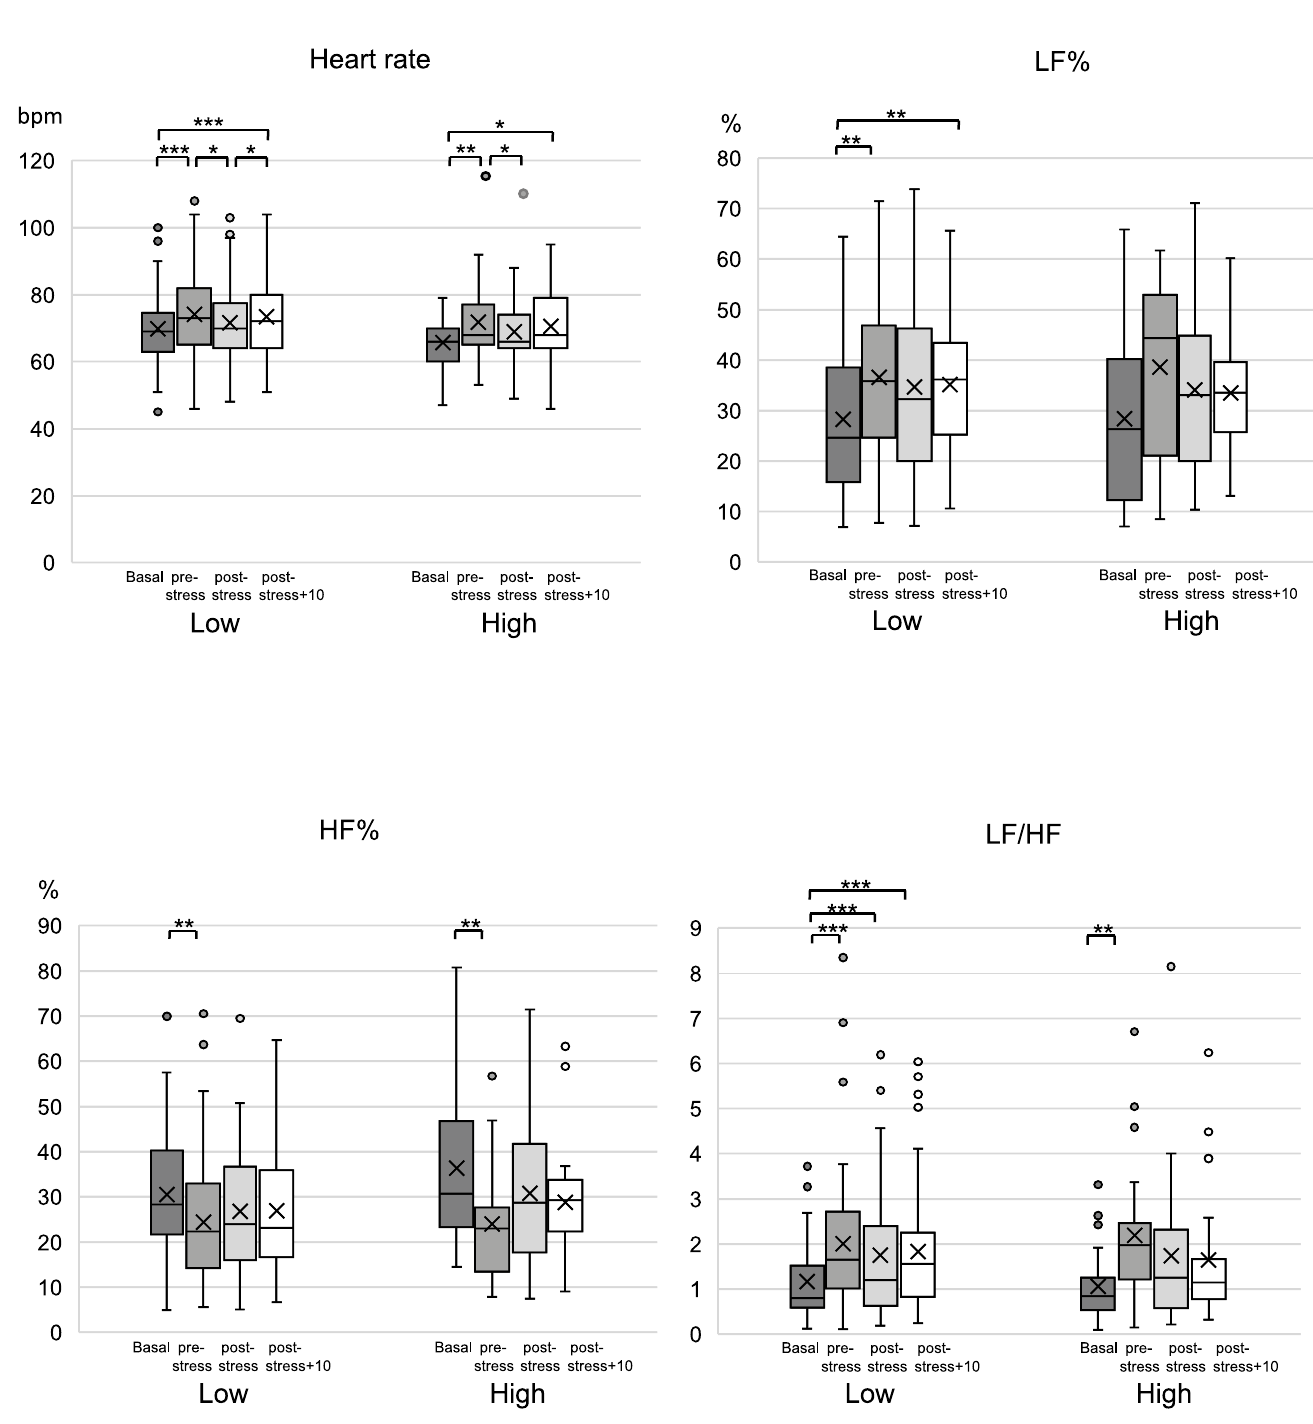
Fig 2. Autonomic nerve activity in response to the TSST. Changes in heart rate (A), LF% (B), HF% (C), and LF/HF (D) in response to the TSST. � indicates significant differences. � p < 0.05, �� p < 0.01, ��� p < 0.001.